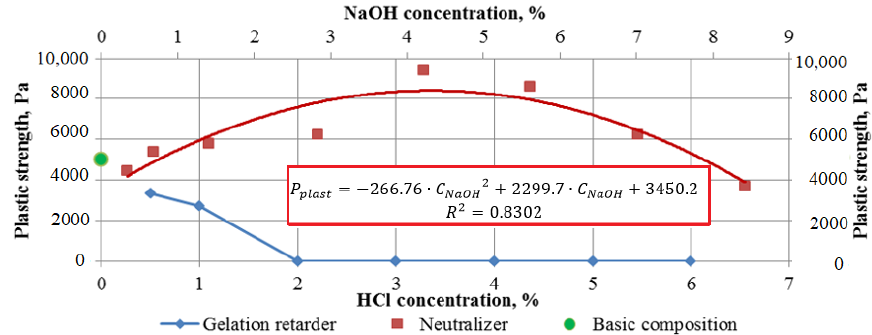
Figure 6. The dependence between the plastic strength ( P s ) and the concentrations of the gelation delayer ( C HCl ), and neutralizer ( C NaOH ) after 24 h, from the time of crosslinking (crosslinker—Cr(CH 3 COO) 3 ). The green point indicates the composition without the gel-time modifier (basic composition).